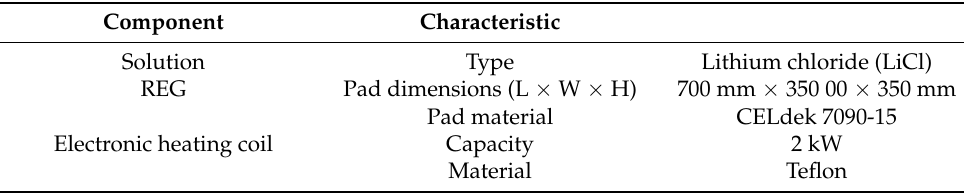
Table 1. Physical information of each component in the experimental setup.